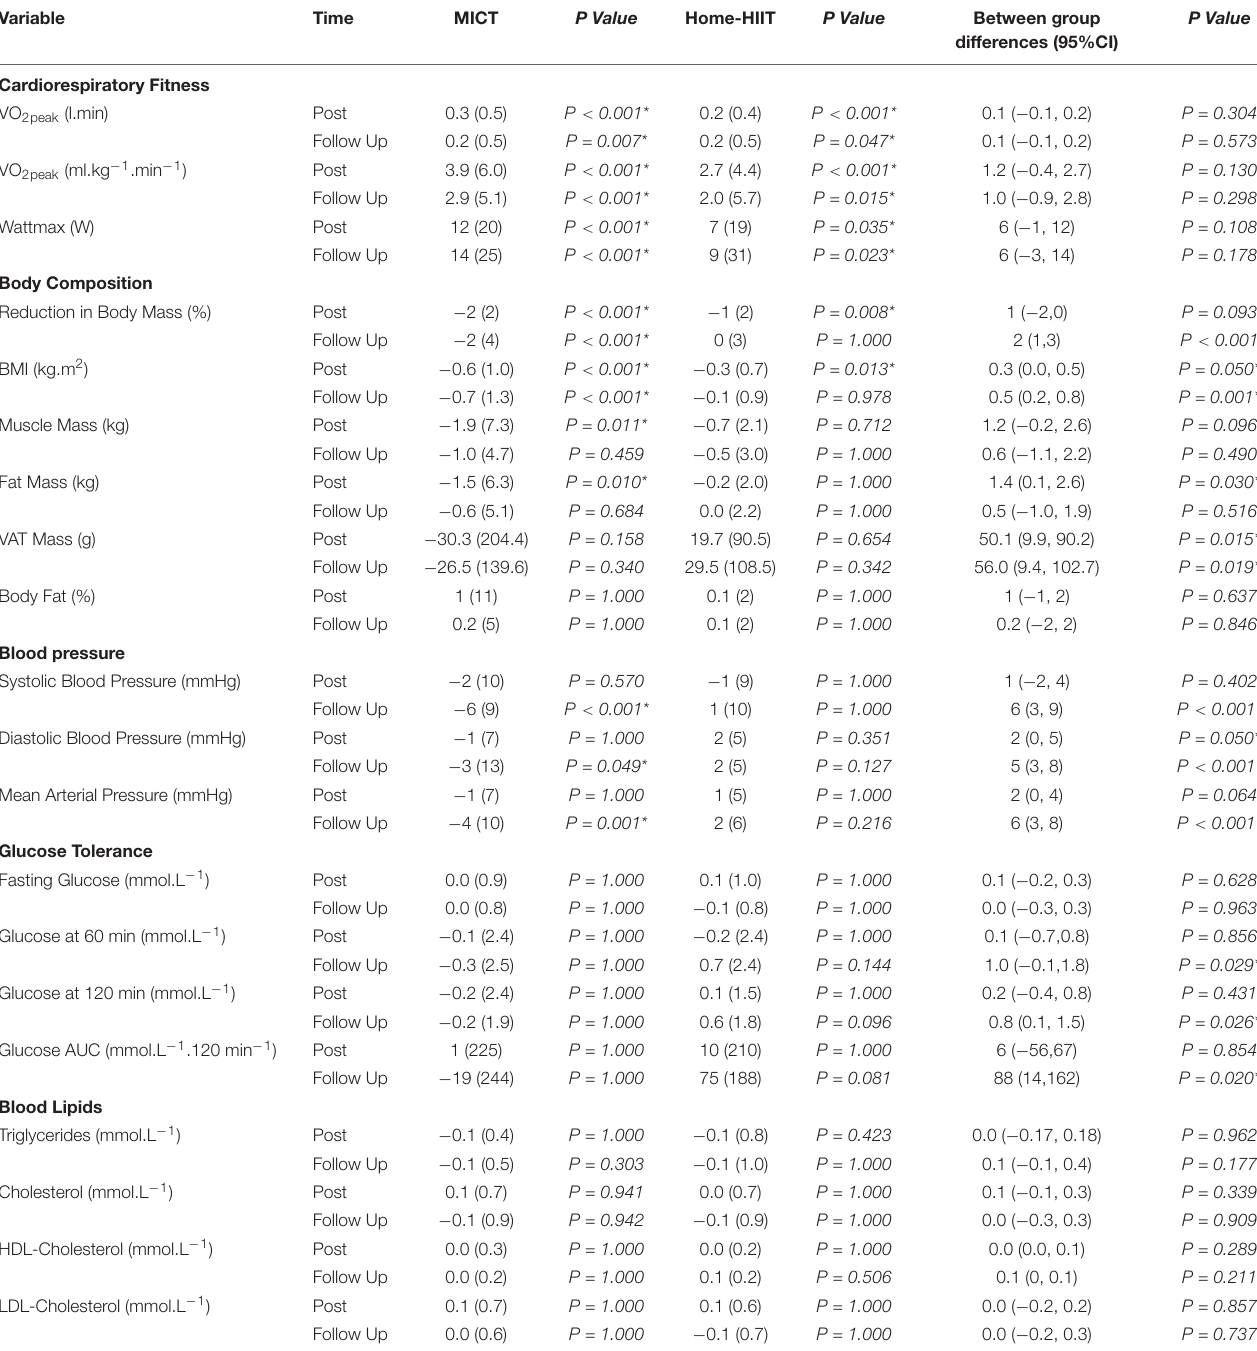
TABLE 4 | Changes to cardiorespiratory fitness, body composition cardiovascular responses, glucose tolerance and blood lipid responses post-intervention and at 3-month follow-up compared to baseline. Variable Time MICT P Value Home-HIIT P Value Between group